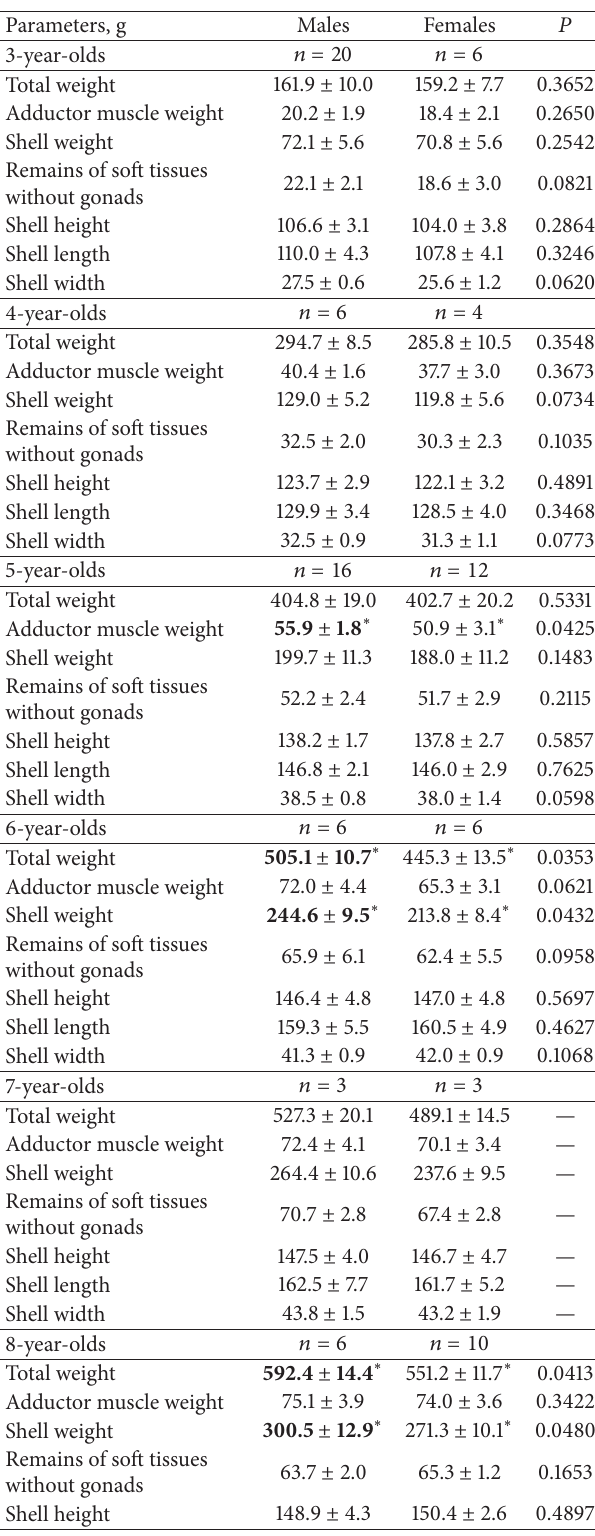
Table 1: Patinopecten yessoensis . Wet weight and size parameters of the same aged males and females from the population inhabiting Melkovodnaya Bay. ∗ indicates significant differences between parameters at a level 𝑃 < 0.05 ( 𝑡 -test). — indicates that data were not compared. Bold marks higher values. 𝑛 is sample